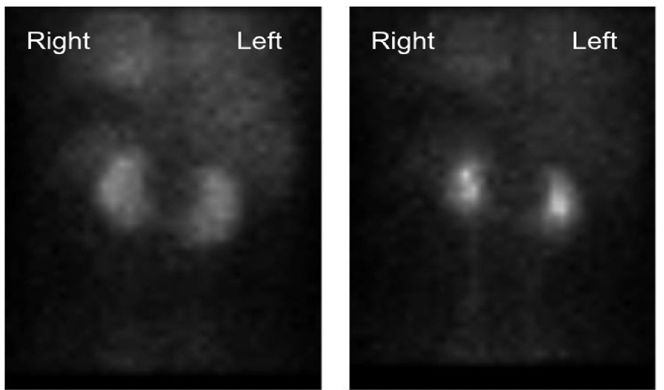
Figure 1. Technetium-99m-DTPA renal scintigraphy revealing an estimated relative GFR values of 54.5% on the left and 45.5% on the right, in addition to a HSK.